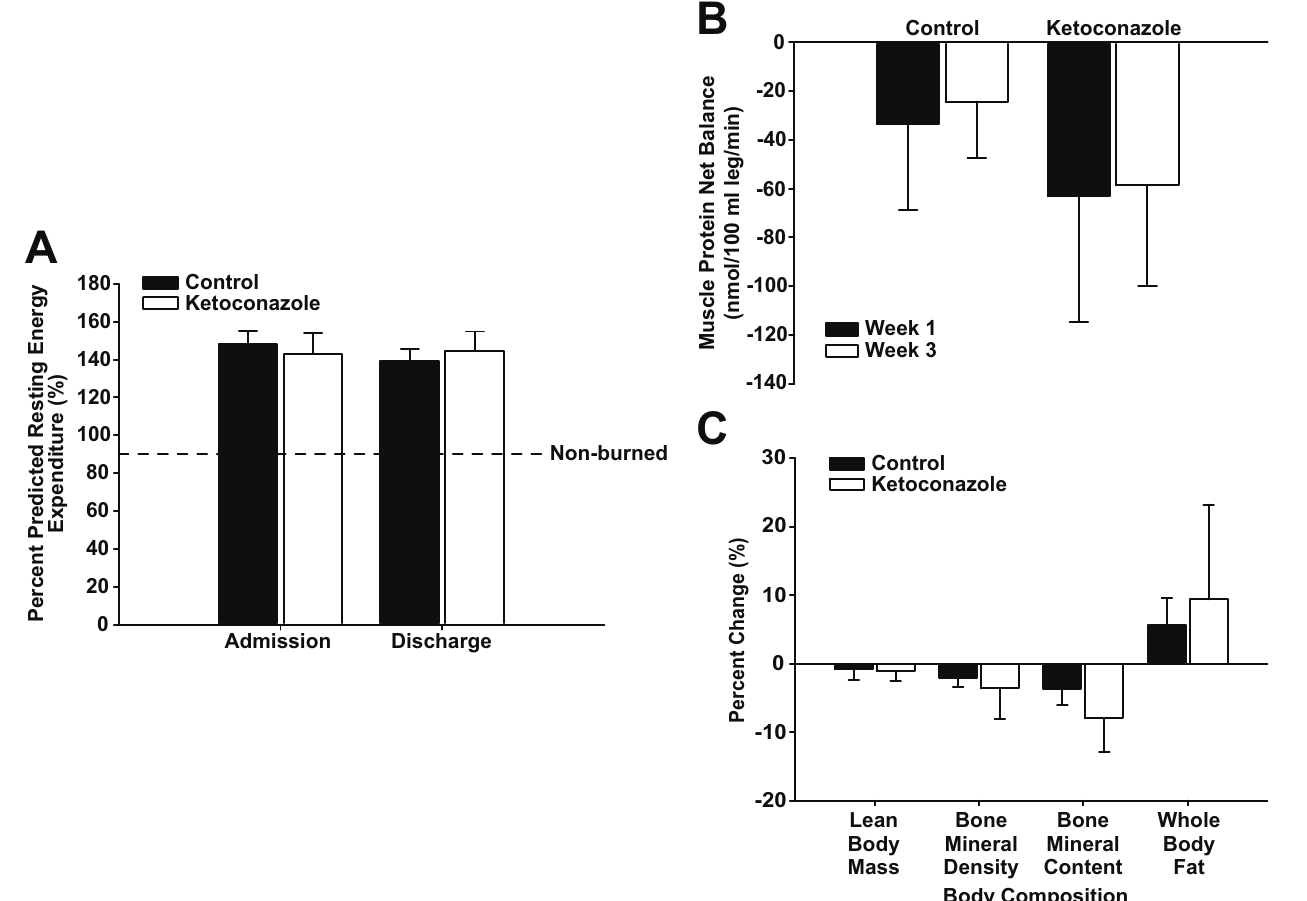
Figure 4. Ketoconazole administration does not alter hypermetabolism or catabolism. Data are presented as mean 6 SEM. A, Resting energy expenditure was significantly higher in control and ketoconazole-treated patients than in non-burned volunteers. There were no significant differences between control and ketoconazole-treated patients. B, Changes in net protein balance induced by burn injury, or more specifically changes in muscle protein synthesis and breakdown, were measured by stable isotope studies using d5-phenyalanine infusion. Black bars indicate week one post burn and white bars week three post burn. There were no significant differences between groups. Both groups were catabolic during the study period. C, There was severe whole-body catabolism post burn. There were no significant differences between